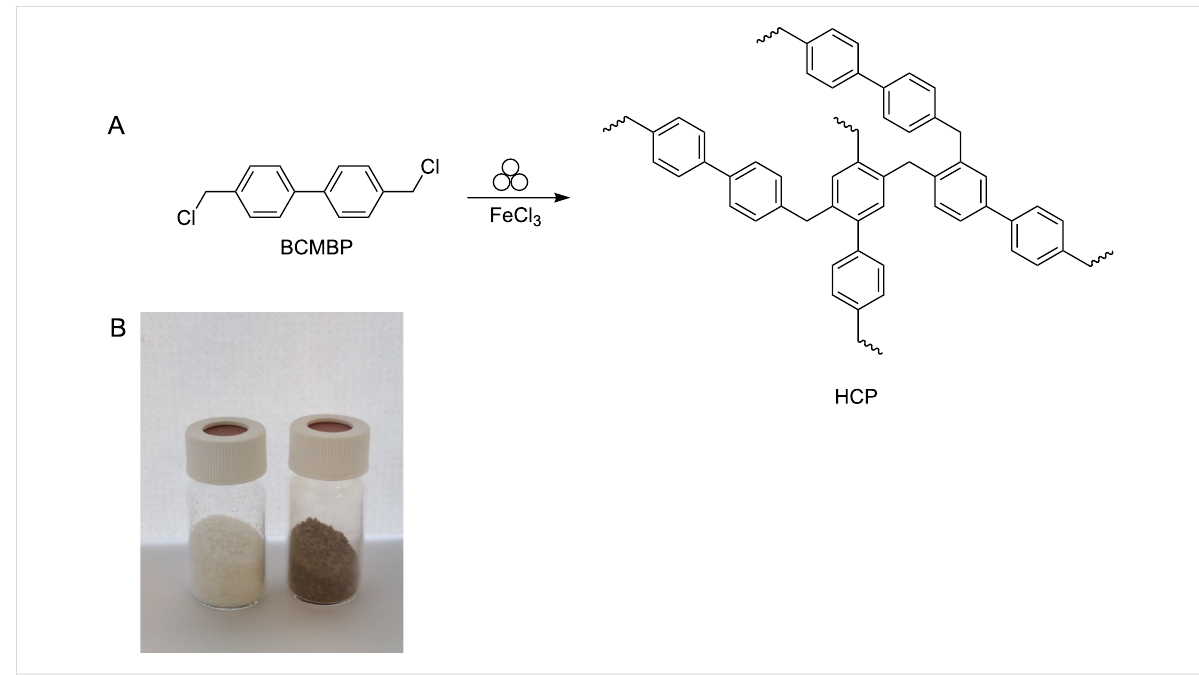
Figure 1: A: Mechanochemical polymerization of BCMBP (4,4’-bis(chloromethyl)-1,1’-biphenyl) towards the porous polymer HCP. B: Picture of a vial of BCMBP (left) and LAG-HCP